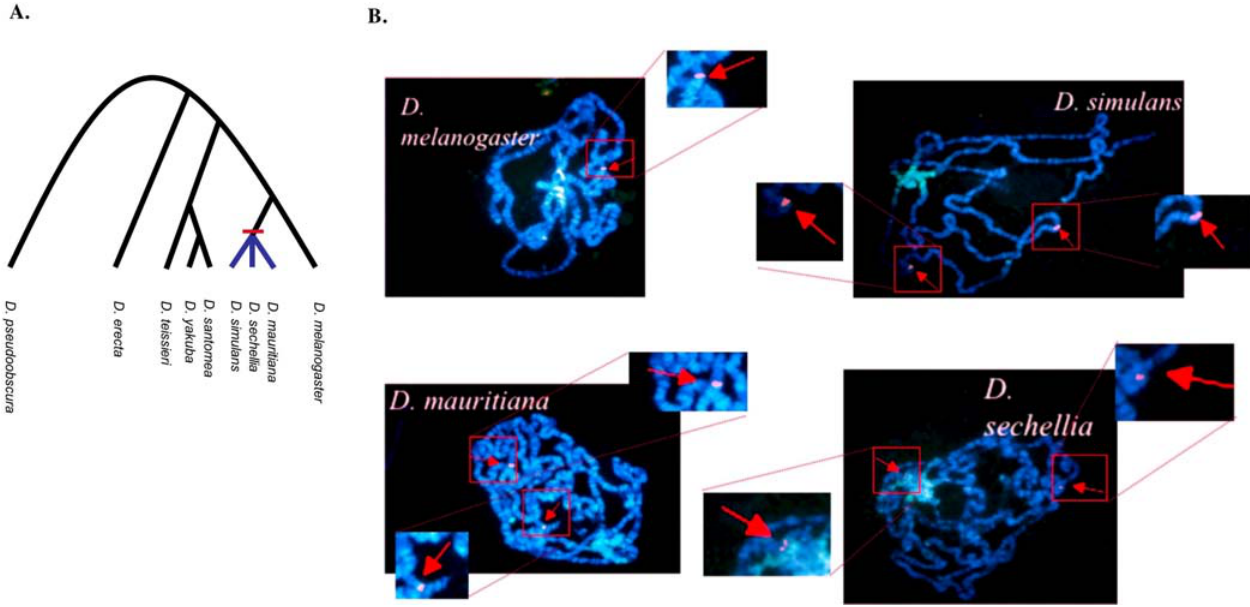
Figure 1. D. melanogaster Subgroup Phylogeny with the Hun Duplication Mapped onto It as Informed by FISH (A) D. melanogaster phylogeny with Drosophila pseudoobscura as the out-group. Red bar indicates Hun duplication, with blue branches below it noting the species in possession of it. (B) FISH was carried out on the D. melanogaster subgroup. Probe signals are indicated by the red arrows. The two signals found in D. sechellia, D. mauritiana, and D. simulans indicate the Hun duplication. Only one signal is found in D. melanogaster, the out-group in this figure, as well as for all other species in the subgroup. FISH images for full subgroup will be provided upon request. DOI: